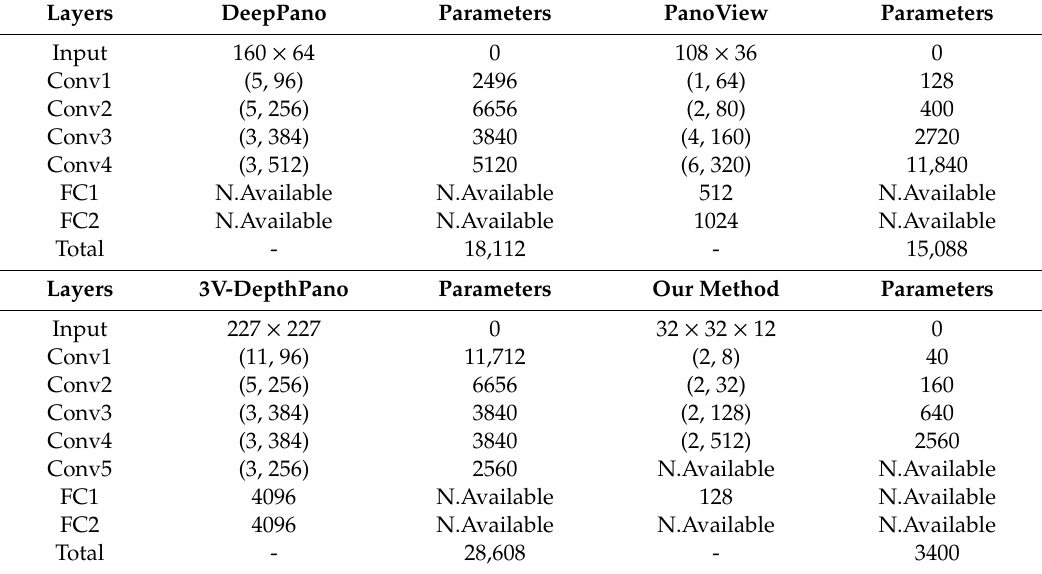
Figure 8. The comparison between the proposed method and other methods, PointNet evaluates only ModelNet10. Table 3. The total parameters for all convolution layers of various methods.